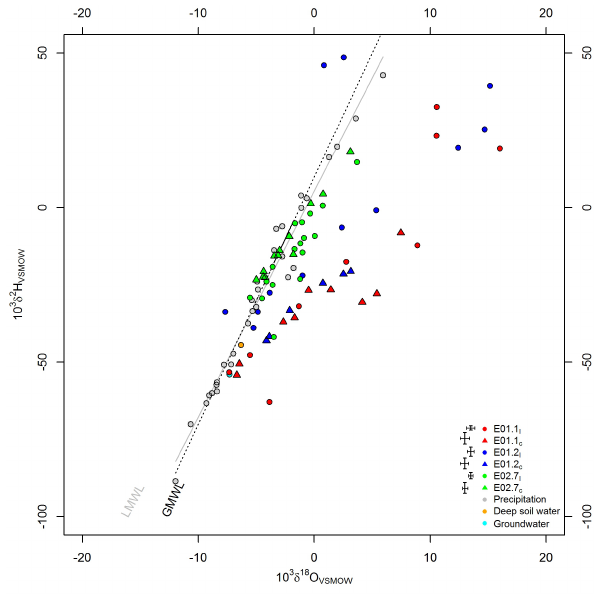
Figure 5. δ 18 O vs. δ 2 H plot of the profiles E01.1, E01.2, E02.7. Further shown is the local meteoric water line (LMWL) for the northern part of Namibia as well as the global meteoric water line (GMWL). A mean value of shallow groundwater is plotted, as well as soil water of a depth profile down to a depth of 4m.